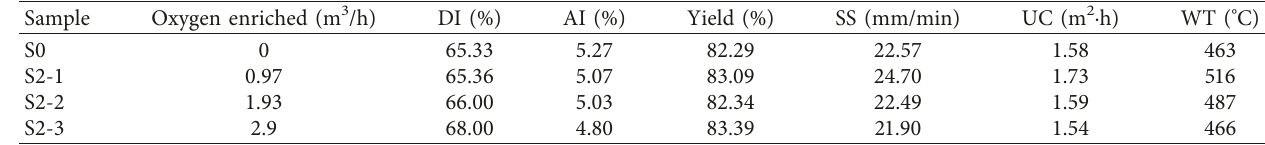
Table 8: Technical indices of the sintering process with different oxygen enrichment loads. Sample